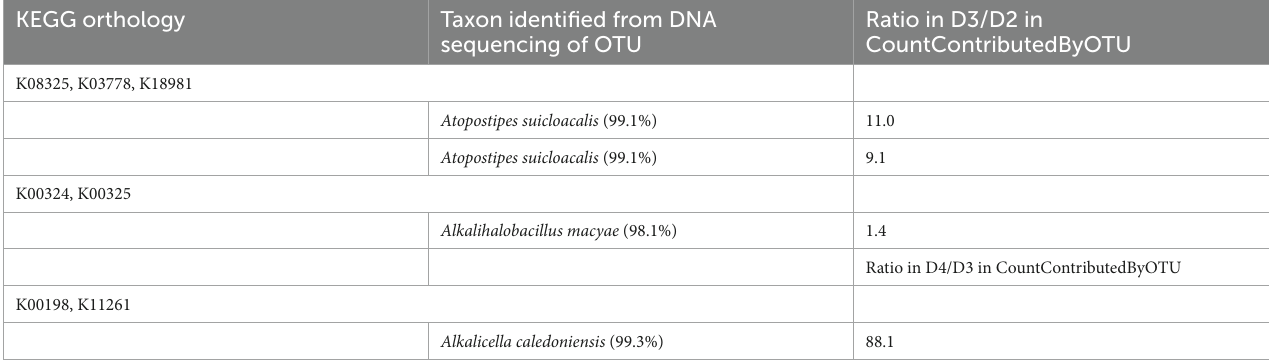
Ratio in D3/D2 in CountContributedByOTU